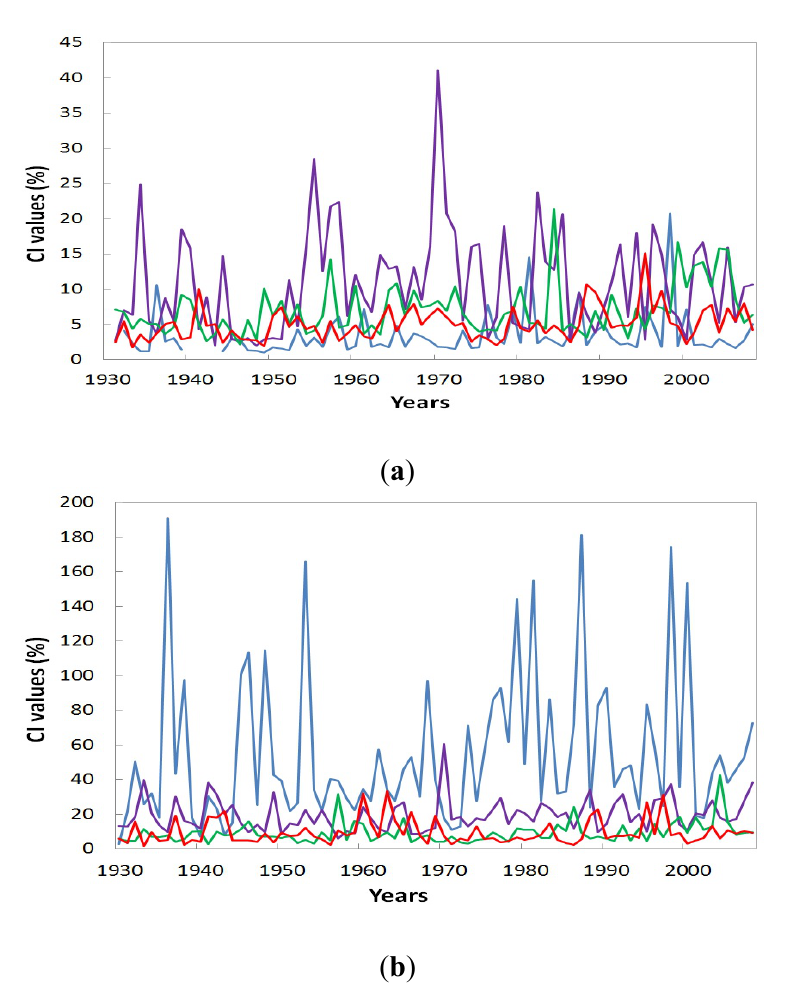
Figure 2. Temporal variability of the CI index in the Matawin River forested watershed ( a ) and the L’Assomption River agricultural watershed; ( b ) for the four seasons. Winter: blue curve; Spring: pink curve; Summer: green curve; fall: red curve. The same trend as for CI is observed for CV values, with breaks in mean values of CV observed for the same seasons as for CI in both watersheds, except for winter in the forested watershed.